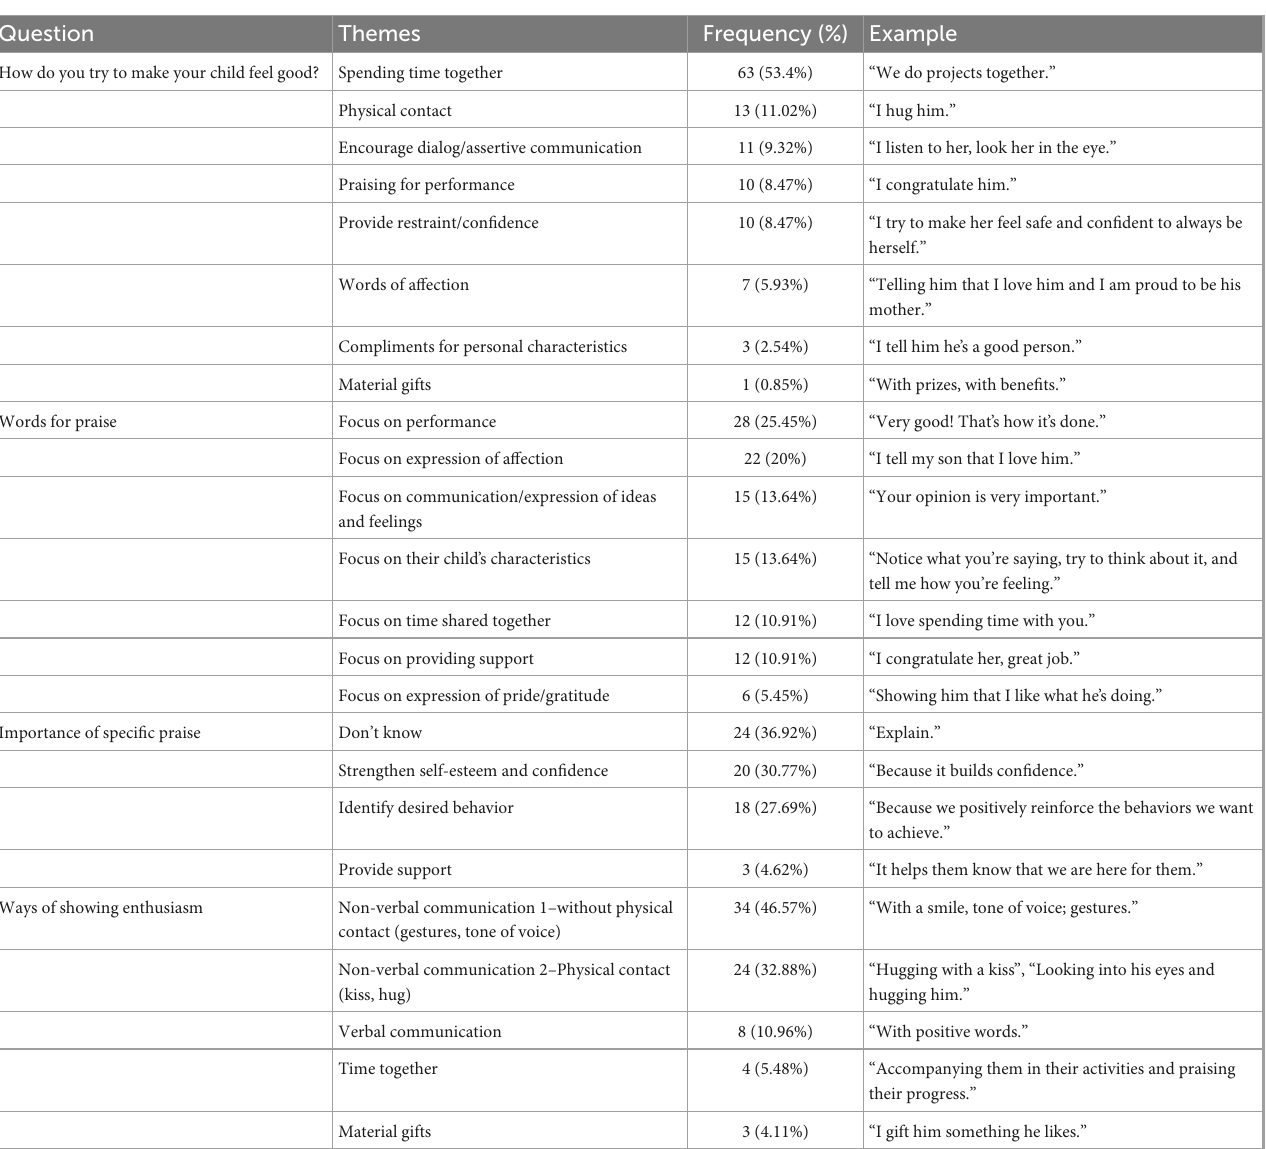
TABLE 2 Qualitative engagement.